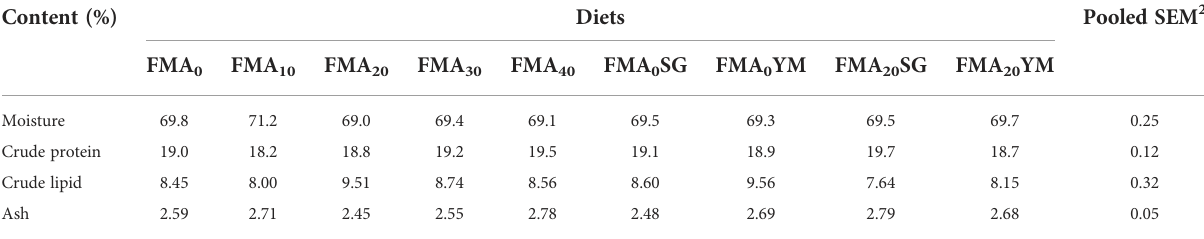
TABLE 3 Whole-body proximate composition of juvenile Japanese eel fed with the experimental diets for 8 weeks (% dry matter basis) 1 . Content (%) Diets